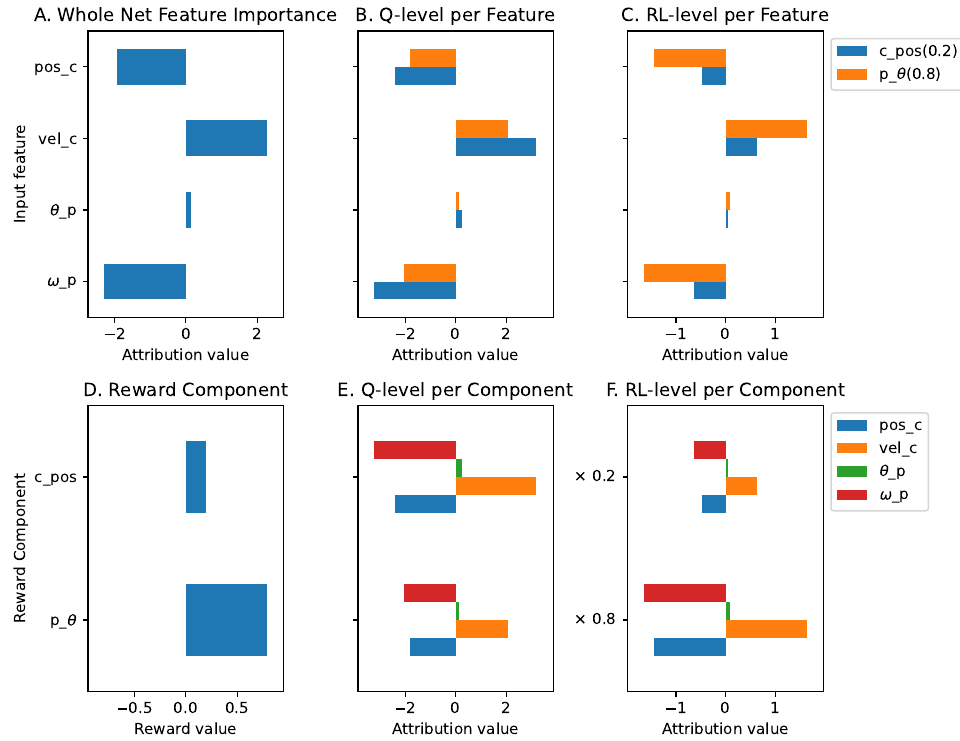
Figure A4. The local explanations of the cartpole when the agent chooses the push-right action.